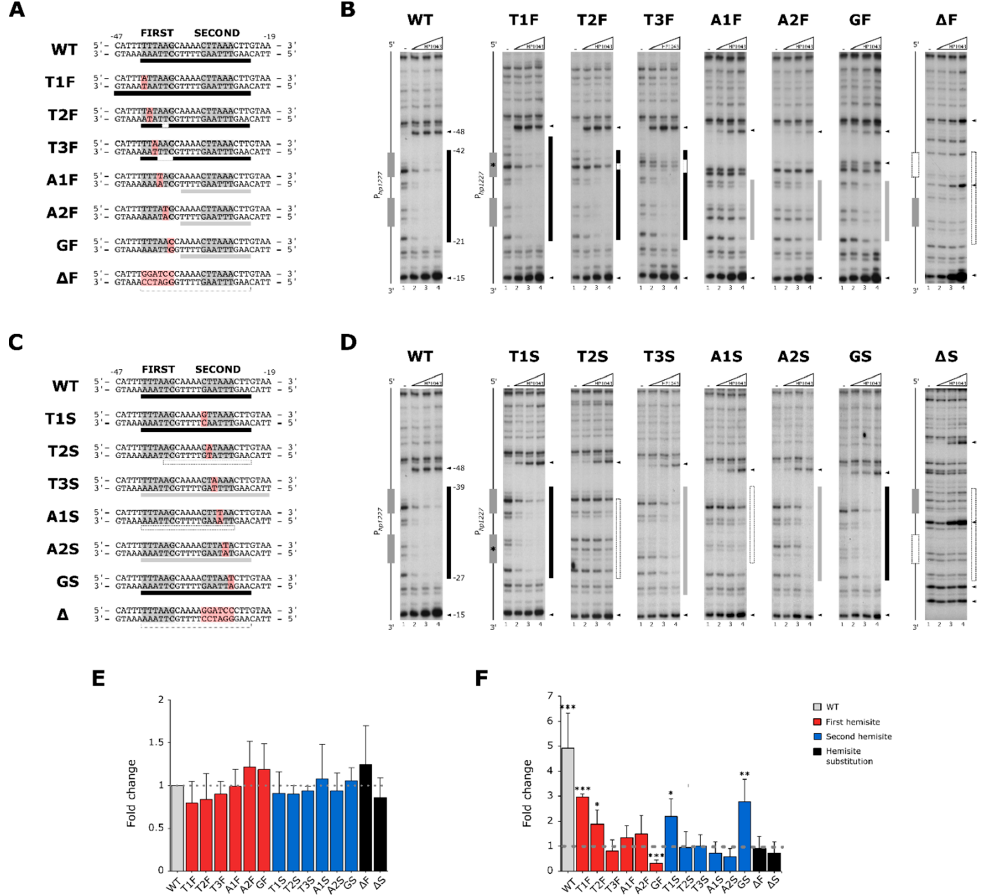
Figure 1. In vitro interaction of HP1043 with WT and mutant P hp1227 promoter probes. Scanning mutagenesis experiments in which single bases of the consensus or one entire hemi-site were mutagenized. ( A , C ) Schematic representation of HP1043 binding site on the P hp1227 probe used for in vitro DNA binding experiments. Hemi-sites of the HP1043 consensus are enclosed in grey boxes while mutations of the probe are highlighted in red. In ( A – F ), WT, wild-type probe; T1F, T2F, T3F, A1F, A2F, GF, ∆ F, mutant probes as reported in panel A; T1S, T2S, T3S, A1S, A2S, GS, ∆ S, mutant probes as reported in panel C. ( B , D ) The same DNase I footprinting experiment was used as a reference, performed in the absence (-) or with increasing amounts of dimeric HP1043 protein (0, 1.7, 6.6, and 13.3 µ M, indicated as a triangle, lanes 1–4, respectively). Grey boxes mark the position of the hemi-sites of the HP1043 consensus sequence on the probe and nucleotide mutations are indicated with an asterisk. In ( A – D ), the length of the bars under the sequences or on the left of in vitro binding assays indicate the coverage of HP1043 protection on the DNA probe from DNase I digestion, while color indicates the strength of interaction, with black representing strong binding, grey intermediate binding, and white loss of binding. Black arrowheads indicate sites of hypersensitivity to DNase I digestion. ( E , F ) In vitro transcription experiments performed on hp1227 mutant promoters controlling the lux operon. In ( E ), basal activity of wild-type (set to 1) and mutant promoters cloned upstream the lux operon in the absence of HP1043. In ( F ), transcriptional variation on the same promoters after the addition of purified HP1043 and RNAP in a 3:1 ratio. Transcriptional variation is indicated as fold-change compared to the WT in ( E ) or compared to basal levels of each condition in ( F ). In ( E ), the basal transcription level of WT is indicated as a grey dotted line. In ( F ), the grey dashed line represents the basal level of transcription of each condition. In ( F ), asterisks indicate the statistical significance of transcription levels in the presence of HP1043 compared to basal levels for each promoter, calculated by Student’s T-test, with * = p < 0.01, ** = p < 0.005, *** = p < 0.001. In ( E , F ), wild-type is represented in grey, single nucleotide mutants of the first hemi-site of the consensus in red, single nucleotide mutants of the second hemi-site in blue, while mutants in which the entire hemi-site was substituted are depicted in